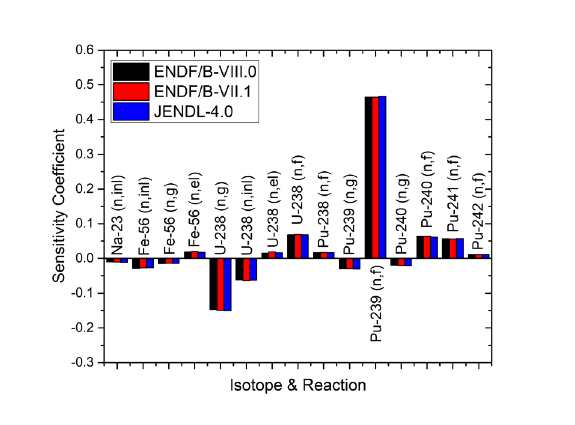
Table 2. k of oxide core at BOC and EOC